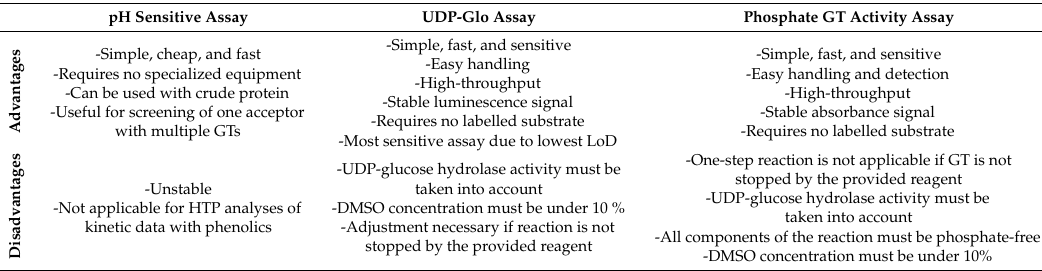
Table 3. Advantages and disadvantages of the three di ff erent detection methods—the